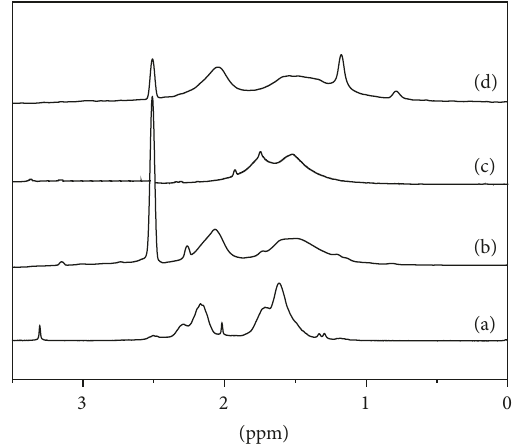
Figure 4: 1H NMR spectra of the polymers: (a) homopolymer PAM in D 2 O, (b) multisticker PAM-co-DAM, (c) telechelic PAM/12, and (d) combined PAM-co-DAM/12 in D 2 O-DMSO